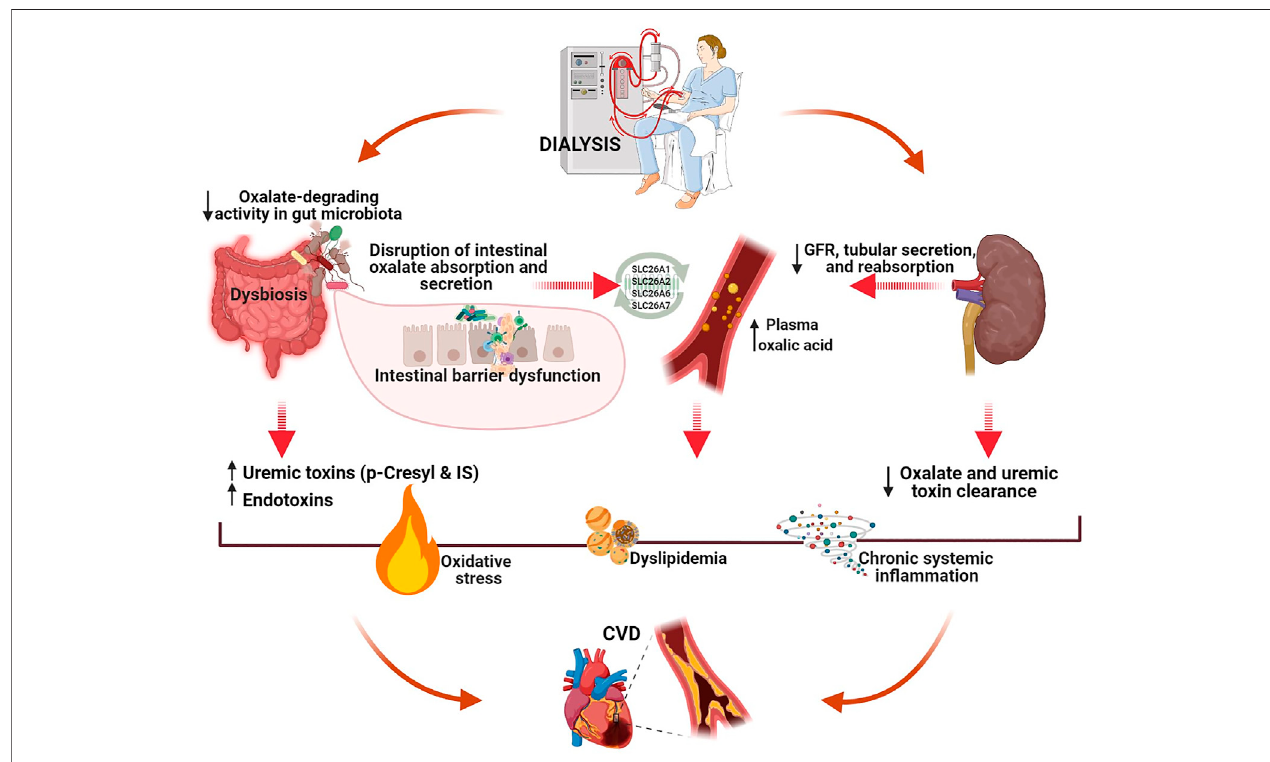
FIGURE 1 | A proposed mechanism of the interaction between oxalate homeostasis and CVD in patients with end-stage renal disease (created with BioRender. com).Intestineplaysacrucialroleinoxalatehomeostasisdisruptioninpatientsondialysis.CKD-associatedgutdysbiosiswithcommensalmicrobiotade fi ciencyleadsto decreasedtotalfecalODA,intestinalbarrierdysfunction,andalterationofoxalatetransportmechanismsintheintestinalepithelium(bothsecretionandabsorption).Both uremia- and oxalate-induced molecular mechanisms initiated in the gut can activate oxidativestress, chronic in fl ammation, and atherogenesis, eventually resulting in CVD.